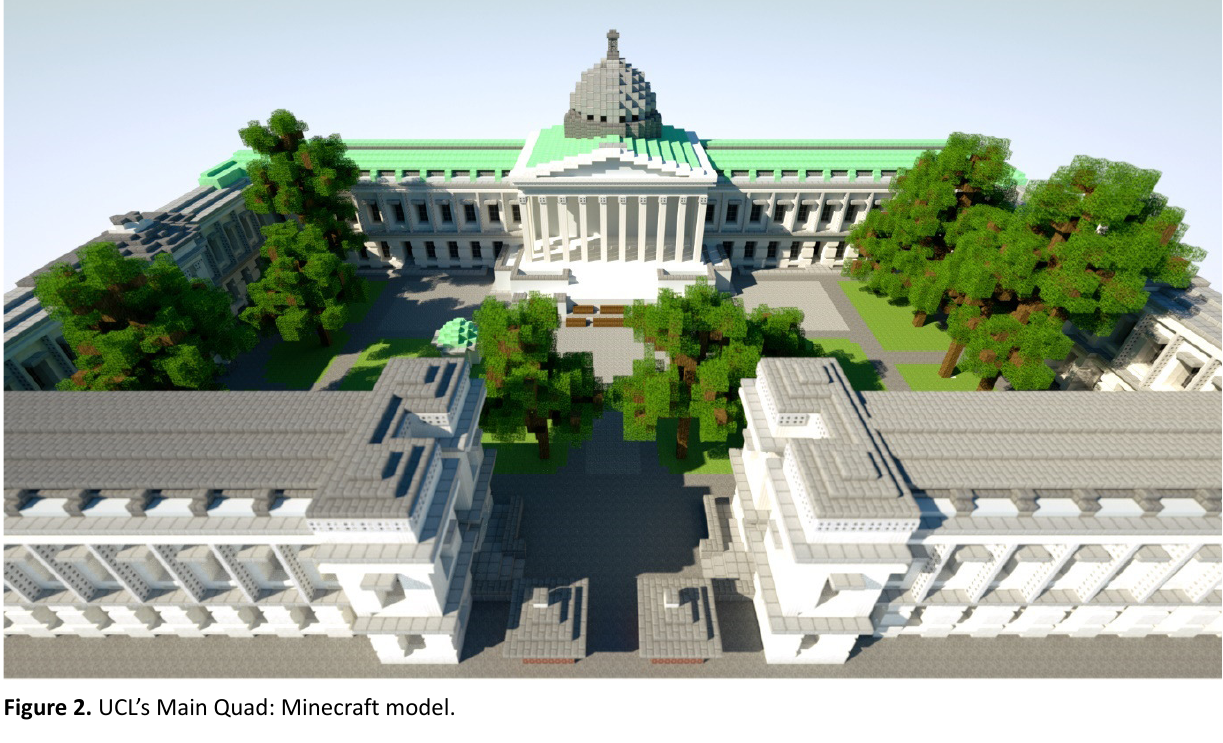
Figure 2. UCL’s Main Quad: Minecraft model.